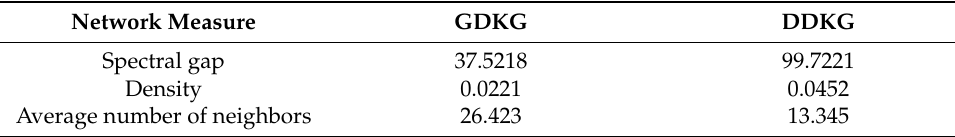
Table 6. Graph theoretic measures for the GDKG and DDKG